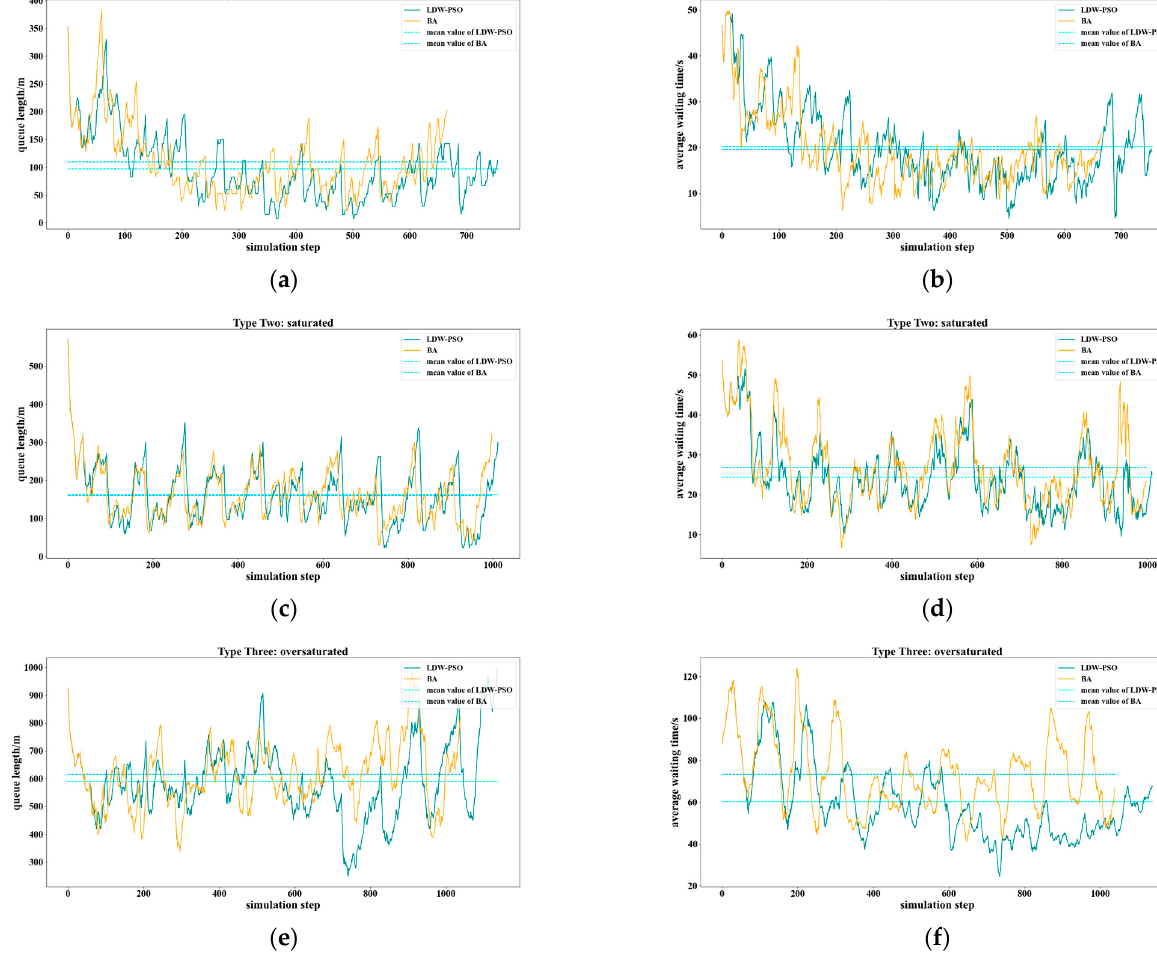
Figure 9. Three conditions’ best optimisation process of queue length and average waiting time. Their mean values are represented with dotted lines. ( a ) Type One’s best optimisation process of queue length; ( b ) Type One’s best optimisation process of average waiting time; ( c ) Type Two’s best optimisation process of queue length; ( d ) Type Two’s best optimisation process of average waiting time; ( e ) Type Three’s best optimisation process of queue length; ( f ) Type Three’s best optimisation process of average waiting time.